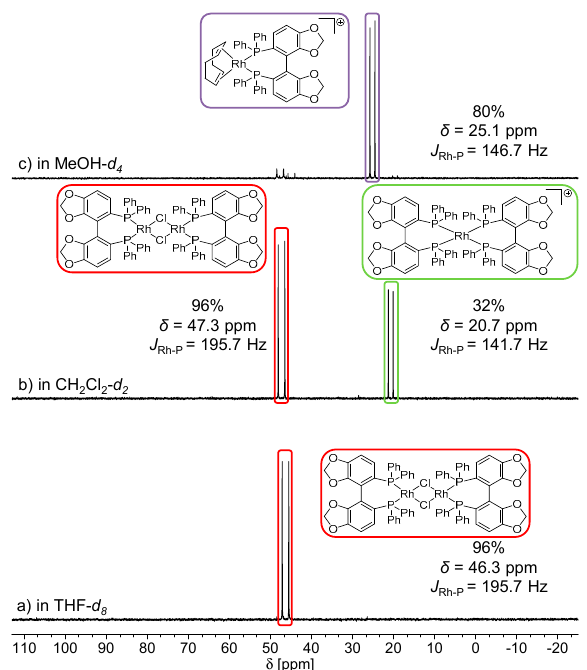
Figure 3. 31 P NMR spectrum of the solution resulting from the in situ reaction of [Rh(COD)( µ 2 -Cl)] 2 and SEGPhos in the ratio 1:2 at room temperature: ( a ) in THF- d 8 , ( b ) DCM- d 2 , ( c ) MeOH- d 4 .